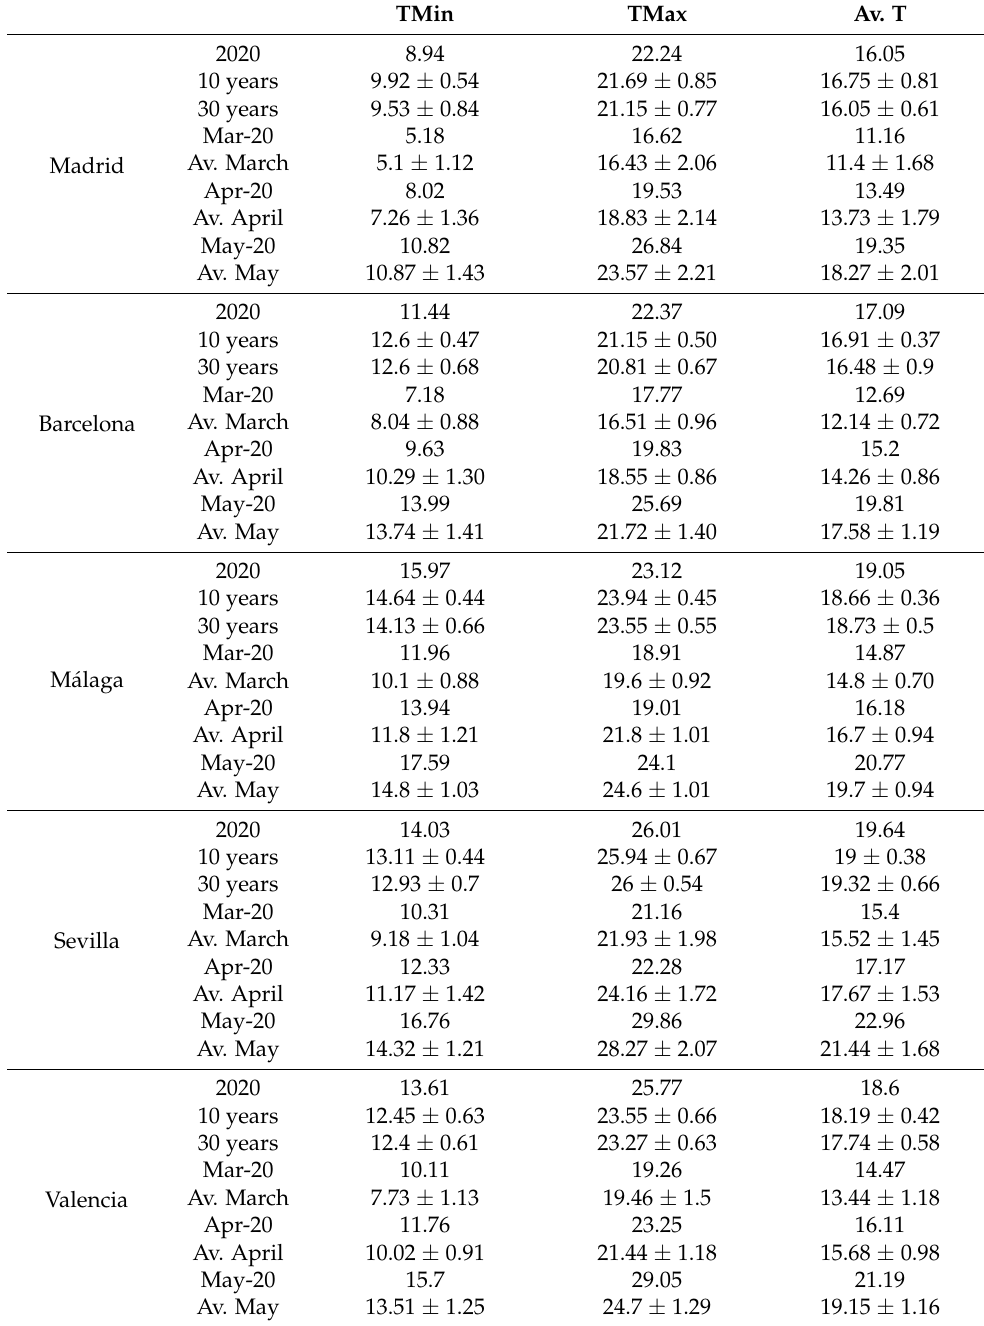
Table 1. Comparison of air temperature values ( ◦ C) in 2020 for the 10 and 30 year data se- ries. TMax = maximum temperature; TMin = minimum temperature; Av.T = average temperature; and ± = standard deviation. TMin TMax Av. T